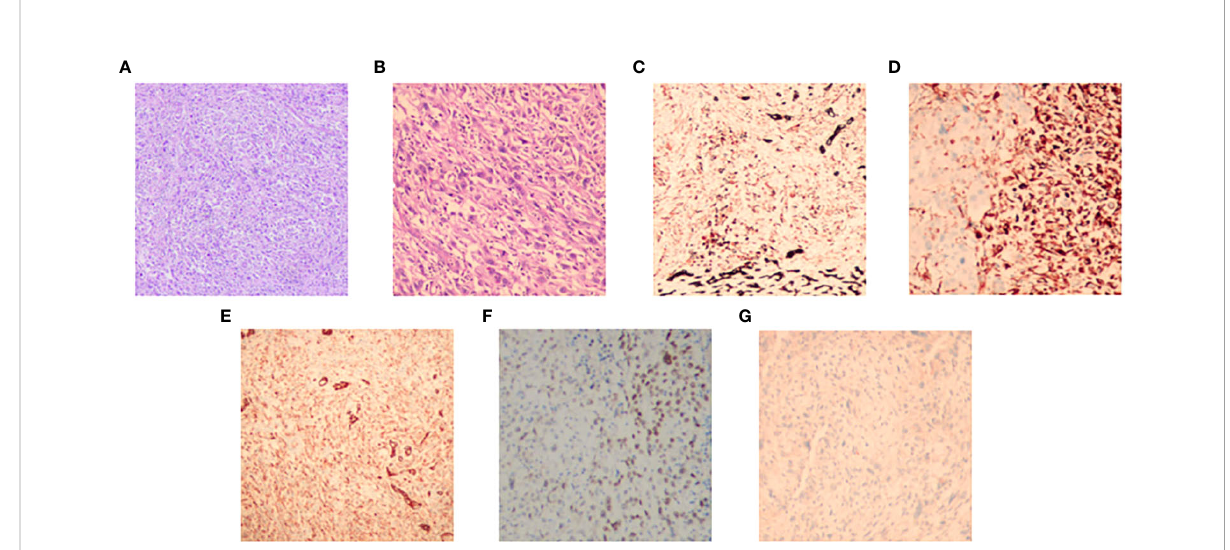
FIGURE 2 The hematoxylin – eosin (H&E) and immunohistochemical pictures of the tumor. (A) H&E, original magni fi cation, ×100. (B) H&E, original magni fi cation, ×400. Immunohistochemistry: CKpan (C) , Vementin (D) , EMA (E) , P63 (F) , and S100 (G)